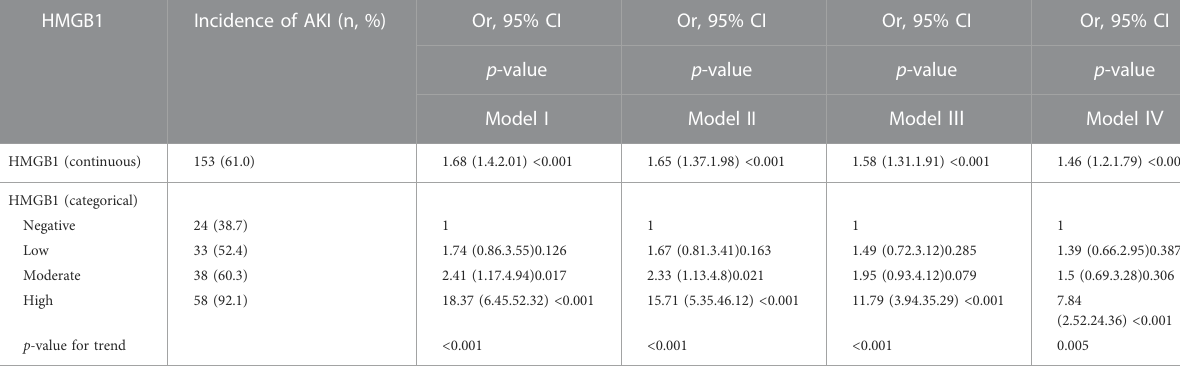
TABLE 4 Adjusted effects of HMGB1 level as a predictor of AKI among individuals with HBV-ACLF during the 90-day follow-up period (n = 251).